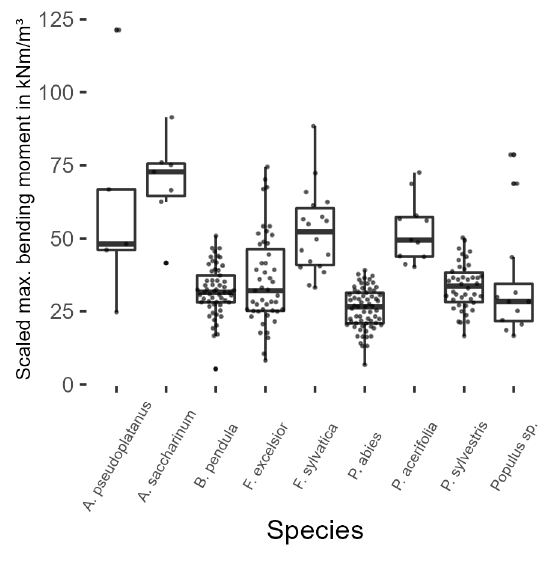
Figure 8. Species effect on anchoring strength. ANOVA: Table